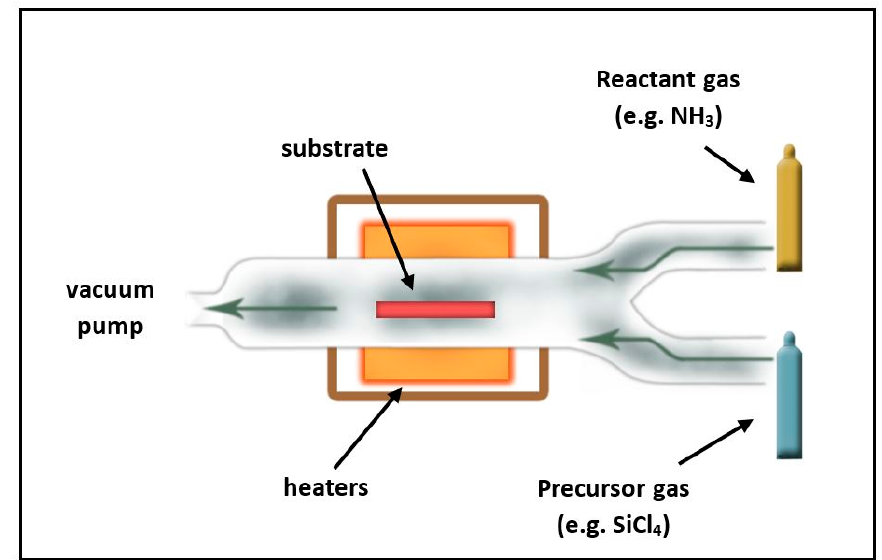
Figure 6. Schematic drawing of a PE-ALD reactor.